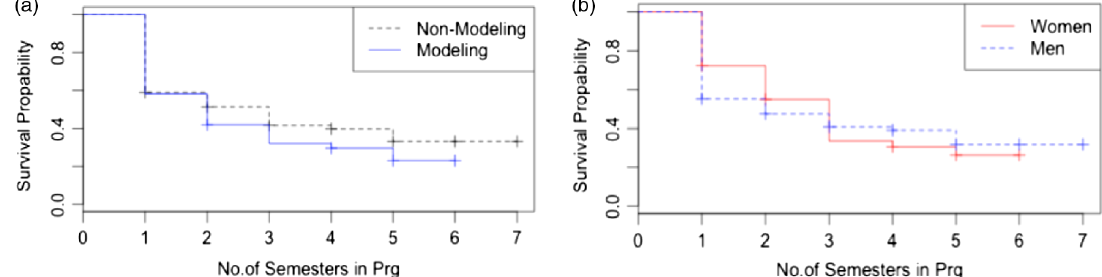
FIG. 2. Majors ’ survival by semester. These survival curves show the probability of surviving the upper level physics courses with each semester. The highest risk of survival is the biggest difference of one semester to the last. In (a) both modeling students and nonmodeling students have the same statistical risk to their survival, where the biggest risk is found in the first semester of upper level physics. (b) Shows that men and women have the overall same statistical risk to surviving their physics courses, where the biggest risk to surviving their courses happens in the first semester of upper level